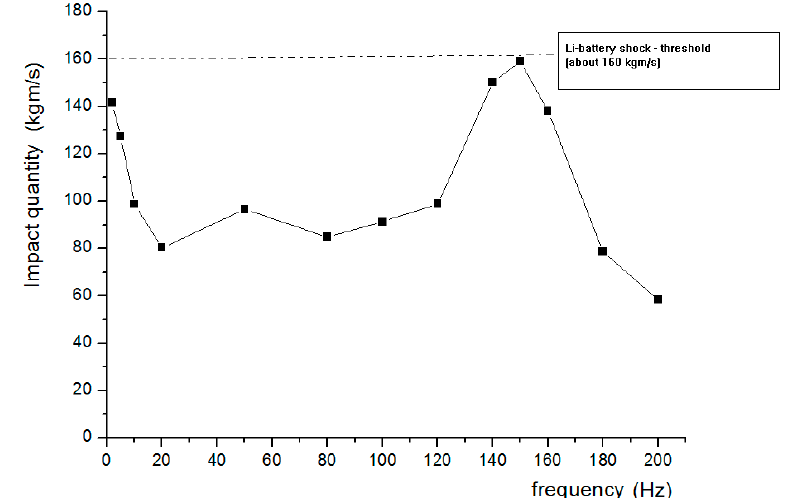
Figure 12. Battery and human body impact time during wheelchair operation.